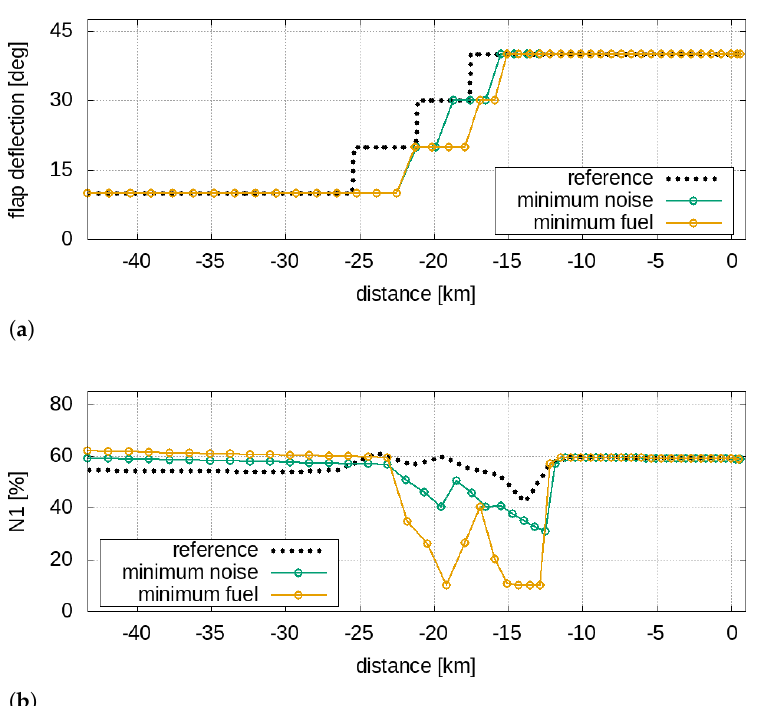
Figure 15. Approach manoeuvre for the twin-aisle aircraft. Procedural variables. ( a ) flap deflection, ( b )